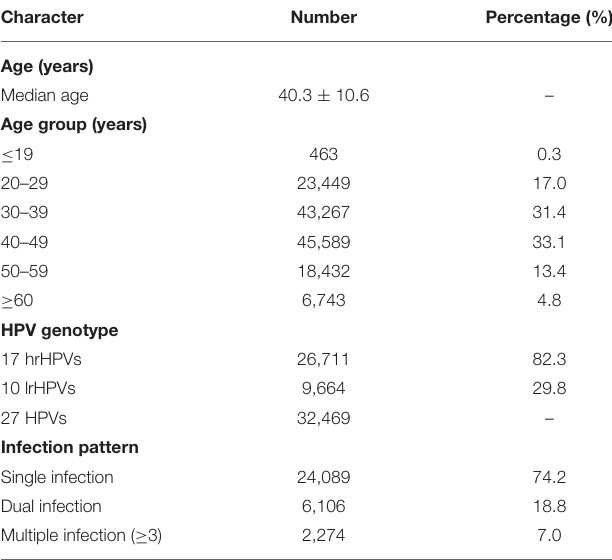
TABLE 1 | Basic character of the study population ( n =